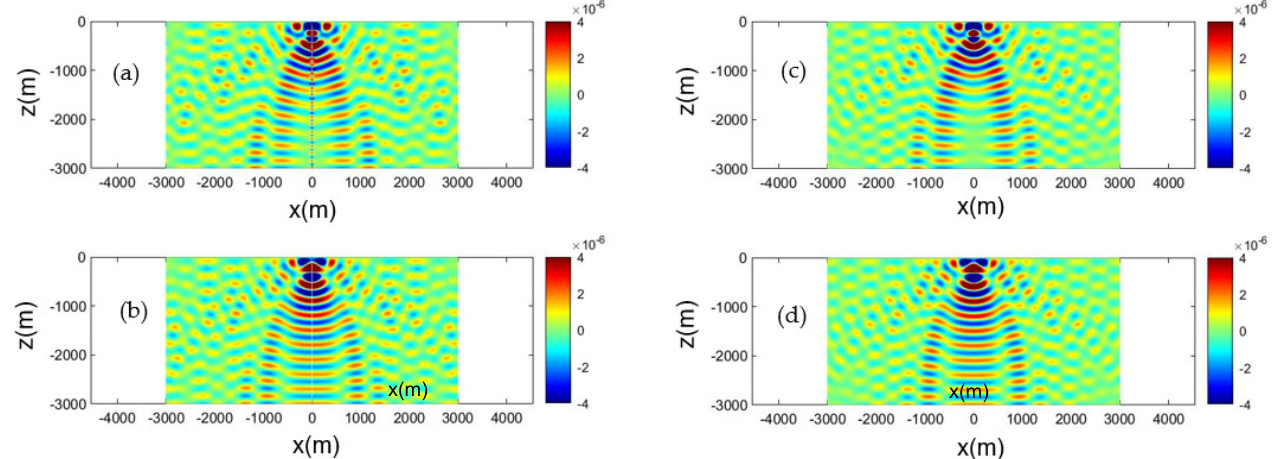
Figure 6. Calculated acoustic field corresponding to the vertical dipole source, Equation (24). Source frequency 5 Hz, at submergence depth z 0 = − 300 m, in an isovelocity c = 1500 m/s ocean acoustic waveguide of depth h = 3000 m. Left column result obtained by the normal mode series, keeping 40 terms: ( a ) real part, ( b ) imaginary part. Right column: field obtained from the mirror series using six terms: ( c ) real part, ( d ) imaginary part.